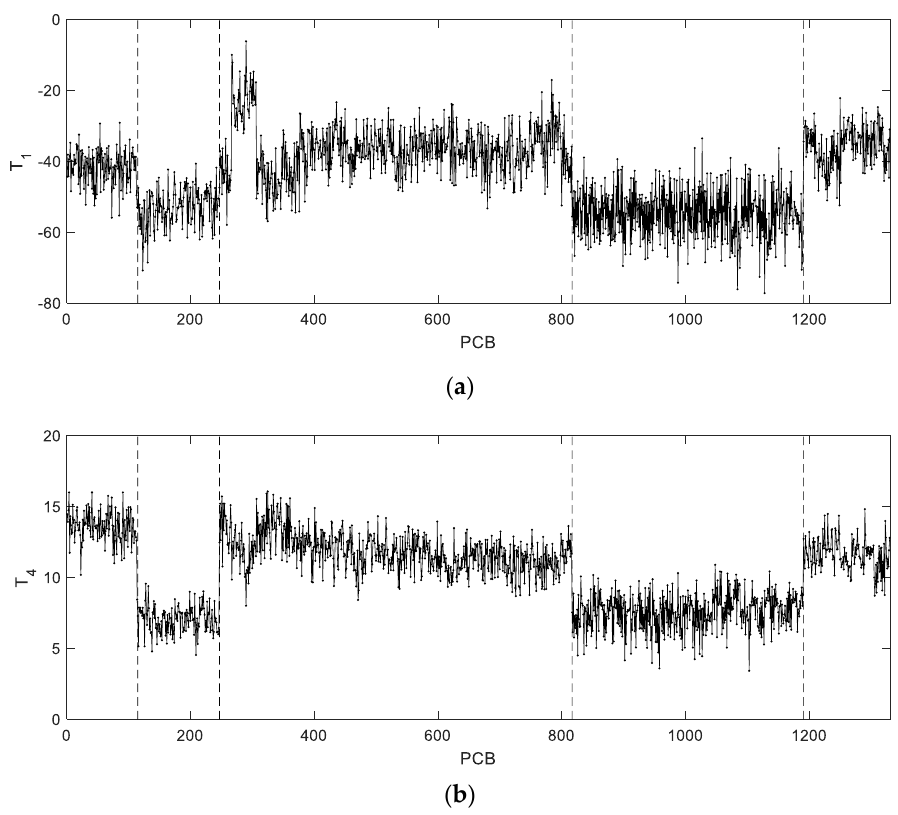
Figure 16. Principal components of CS3: ( a ) first principal component; ( b ) fourth principal component.